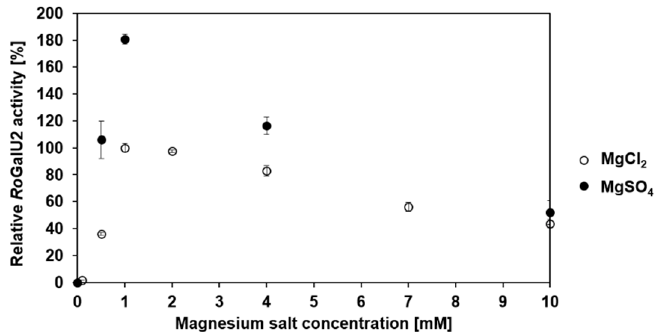
Figure 7. Relative Ro GalU2 enzyme activity depending on the MgCl 2 and MgSO 4 concentration between 0 mM and 10 mM. Assay mixture contained 2 mM UTP, 2 mM glucose 1-phosphate, 0–10 mM MgCl 2 or MgSO 4 , 50 mM Hepes buffer, pH 7.0, 30 µg Ro GalU2. Reaction was carried out at 42 °C in 1 mL reaction volume. Means with standard deviations of triplicate measurements are shown. 100% relative Ro GalU2 activity correspond to 5.2 U mg − 1 .